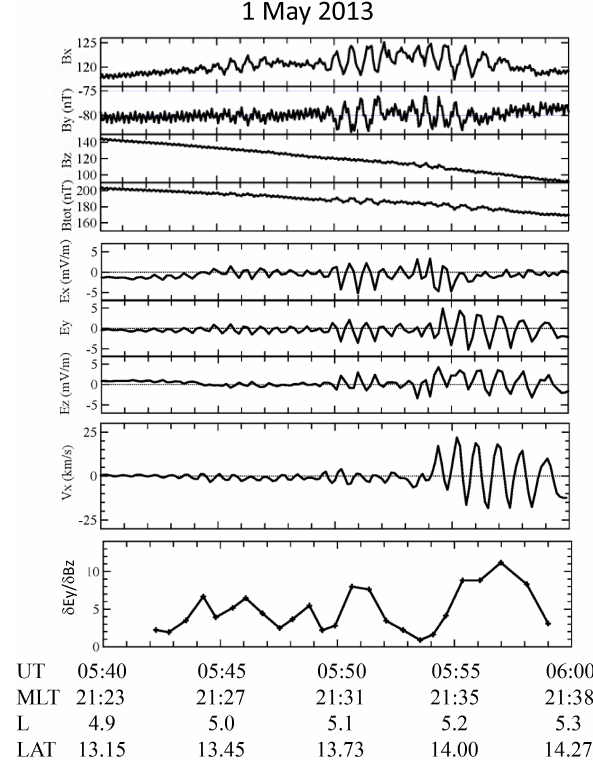
Figure 2. Wind magnetic field and plasma observations from 04:05 to 04:55UT. Dynamic pressure; ion density; GSM V x , Vy , V z , and V tot; and GSM Bx , By , Bz , and B tot are plotted from top to bottom panels, respectively.